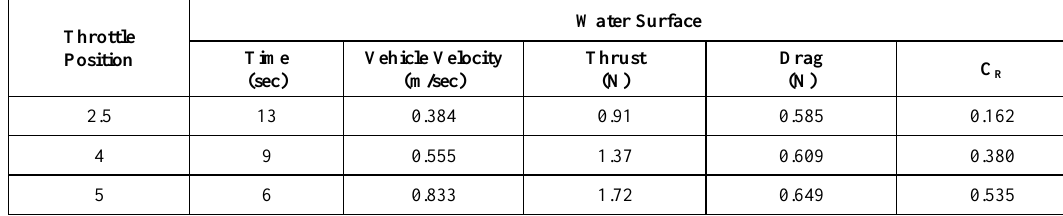
Table 6. Performance of hovercraft in water